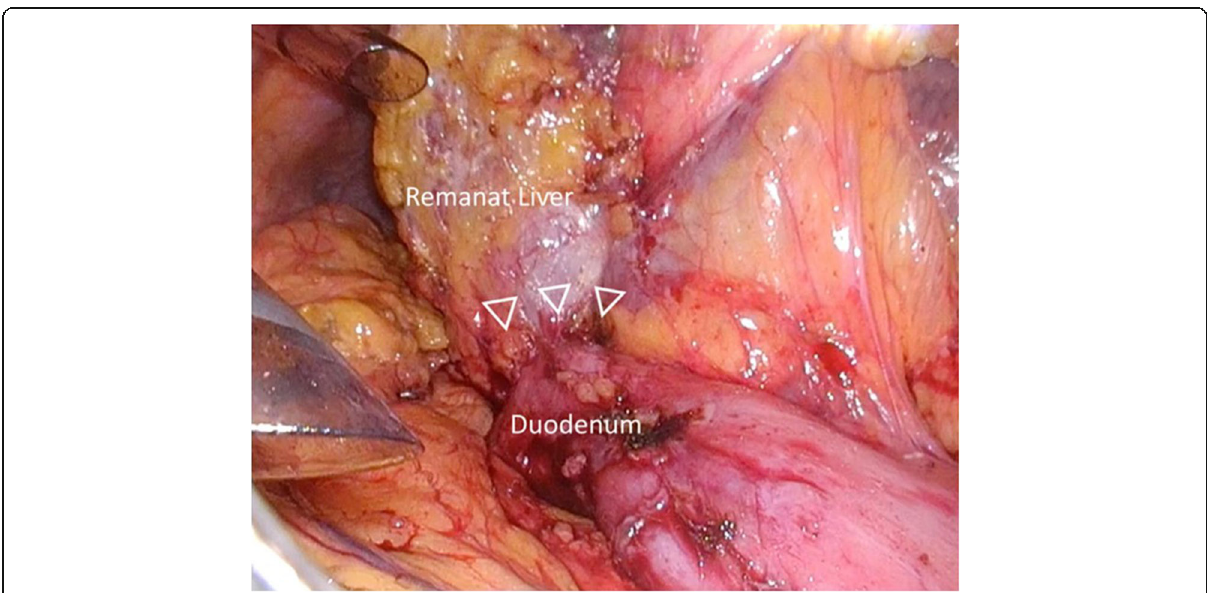
Fig. 2 Rigid adherence of the duodenal bulb to the adjacent hepatoduodenal ligament was formed